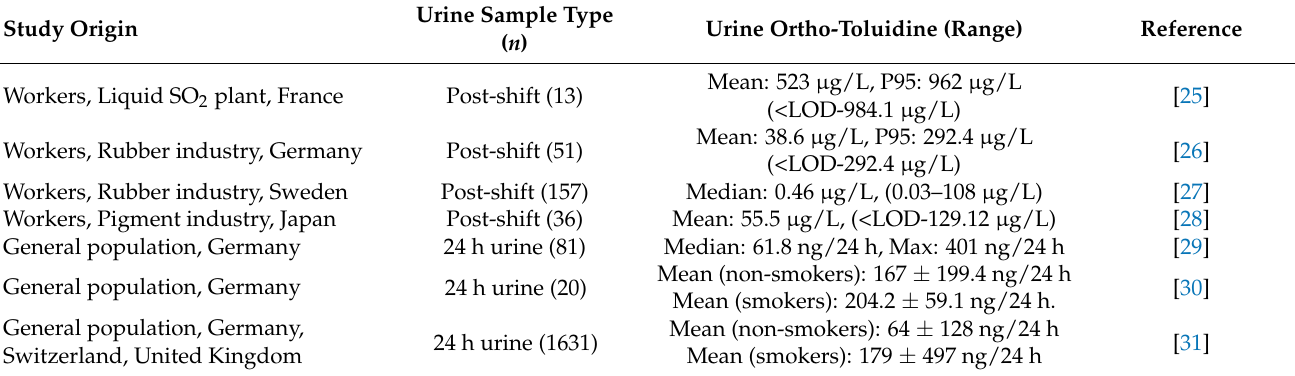
Table 4. Human biomonitoring studies for ortho-toluidine in occupational settings and background concentrations of the general